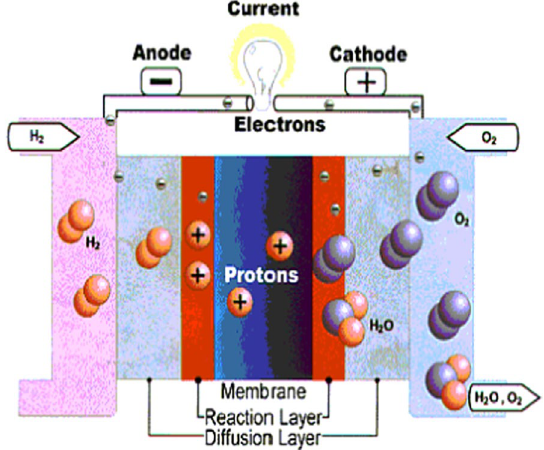
Fig. 10 Hydrogen fuel cell (Bishop